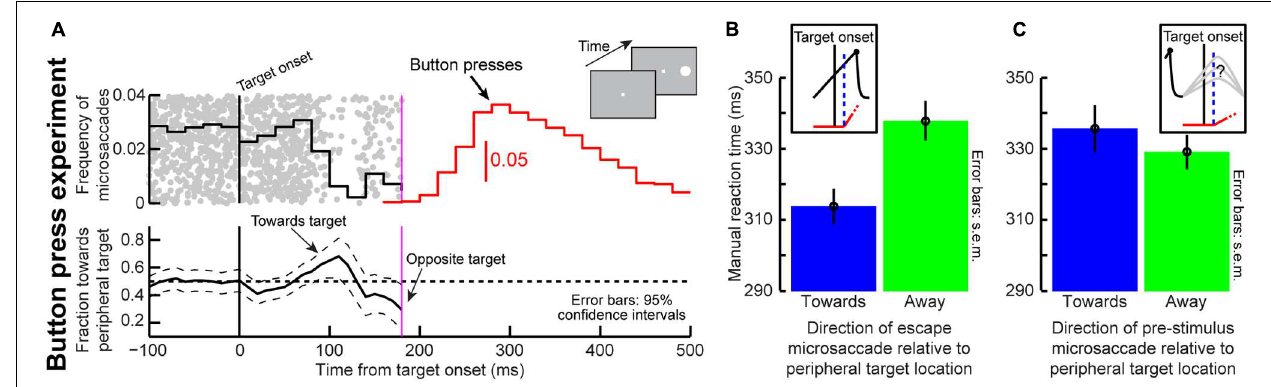
FIGURE 9 | An influence of microsaccades on manual RT’s. (A) Microsaccade frequency (top panel) and direction (bottom panel) in a simple fixation task (inset). Human subjects fixated and pressed a button as fast as possible when a target appeared. Near target onset, microsaccade frequency behaved similarly to microsaccade frequency near target onset in our earlier cueing task with saccades as the response modality ( Figure 4 ). Microsaccade direction also behaved similarly, showing an early bias toward the target and then a later bias opposite (Hafed and Ignashchenkova, 2013). N = 3,628 trials. All conventions are similar to Figure 4A . (B) We tested the prediction that current microsaccadic planning phase at target onset influences manual RT’s (see Figure 1 ). We analyzed manual RT on trials with target onset before microsaccades in different directions (see Materials and Methods). Manual RT was faster if the target was congruent with upcoming microsaccade direction (blue) than if it was opposite (green; p = 0.0015, t -test, N = 187 same, N = 192 opposite). (C) This effect disappeared when the microsaccade ended before target onset ( p = 0.412, N = 214, N = 210). This is so because there is no differential effect of microsaccade directions in the post-movement interval (Chen et al., 2015; Figure 1B ). Error bars denote 95% confidence intervals in (A) and SEM. in (B,C)